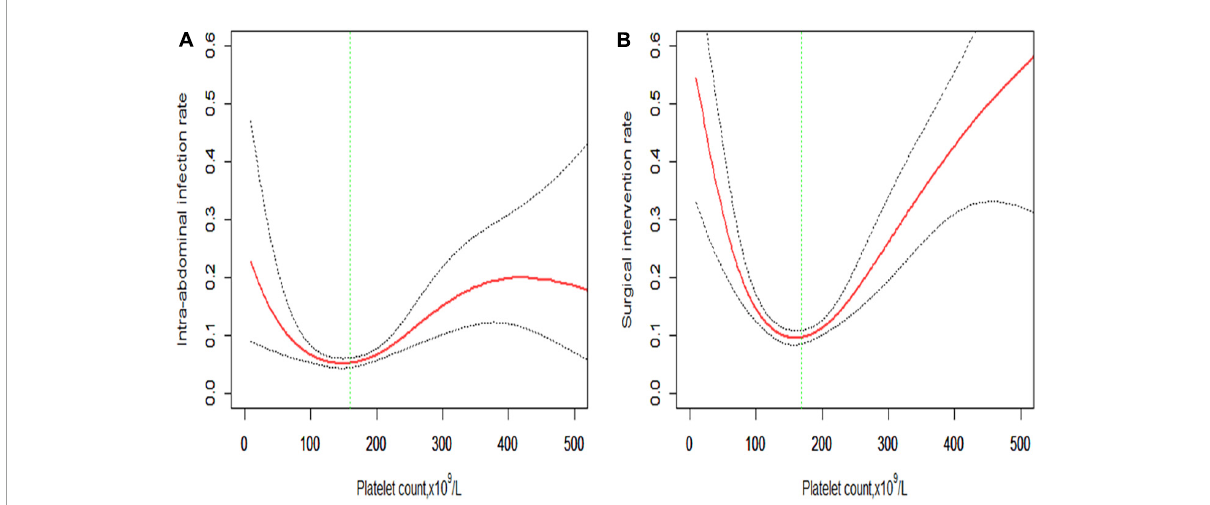
FIGURE2 Non-linear relationship of (A) intra-abdominal infection rate and (B) surgical intervention rate with platelet count. The smoothing splines are generated utilizing a generalized additive model adjusted for age, gender, body mass index, comorbidities (hypertension, diabetes, cerebrovascular diseases, cardiovascular diseases, chronic kidney diseases, and chronic obstructive pulmonary diseases), etiologies (biliary, hypertriglyceridemia, alcoholic, or others), creatinine, C-reactive protein, procalcitonin, lactate, D-dimers, and APACHE II score. The red line indicates the estimated risk rate, the gray dot line indicates 95% confidence intervals, and the vertical green dot line indicates the inflection point.